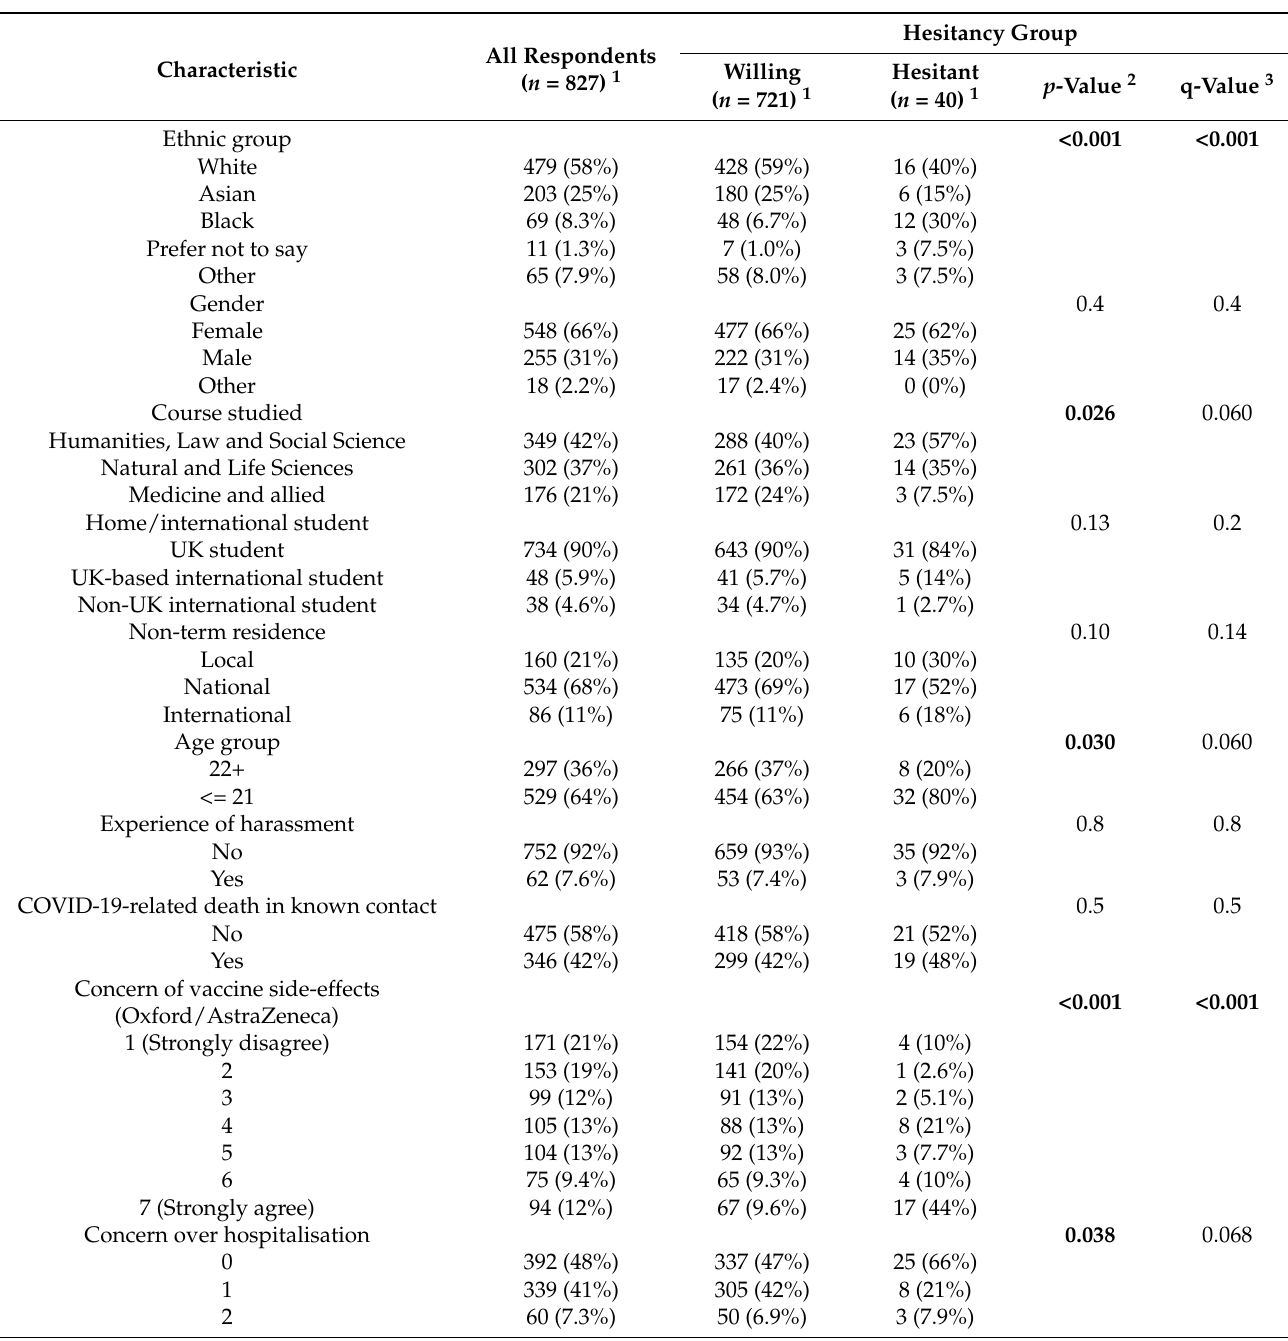
Table 1. Demographic characteristics of study participants and results of an unweighted univariate analysis of vaccine